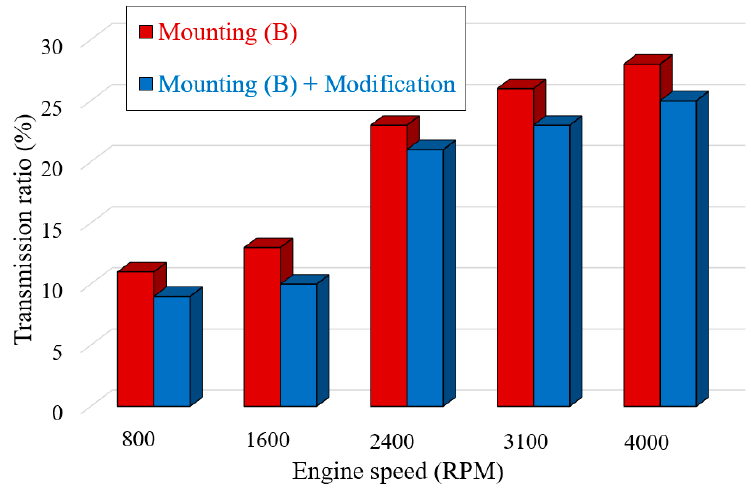
Figure 4. Improvement in transmission ratio after applying the concentrated mass at all speeds [14].